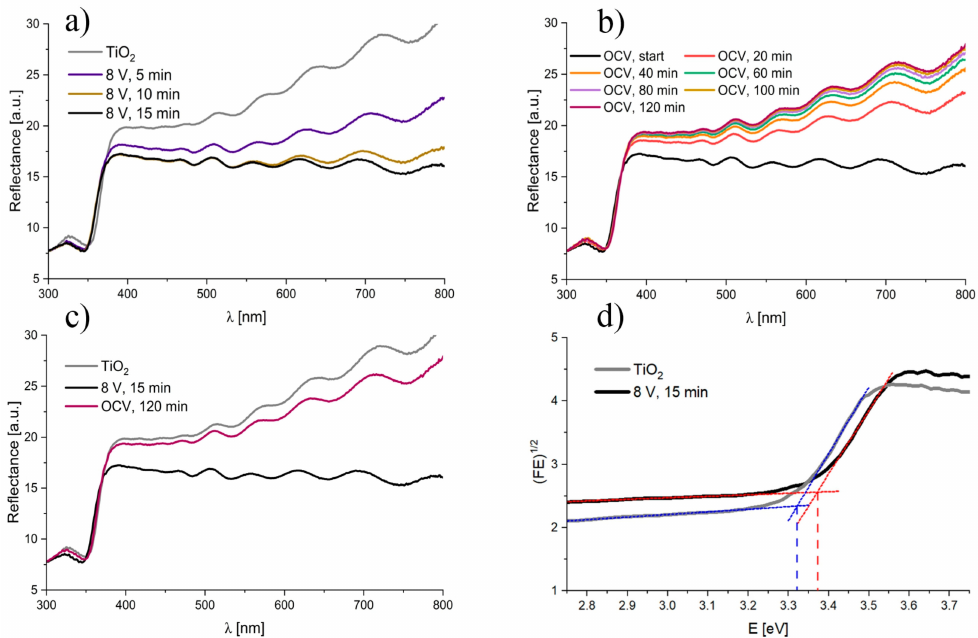
Figure 5. UV–Vis diffuse reflectance spectra recorded ( a ) before and during the cathodic reduction of TiO 2 nanotubes at 8 V, ( b ) during OCV conditioning after the completion of the electroreduction of TiO 2 nanotubes, ( c ) for the sample before and after electroreduction for 15 min at 8 V, and after 120 min at OCV conditions. Tauc plots for ( d ) TiO 2 before and after reduction at 8 V for 15